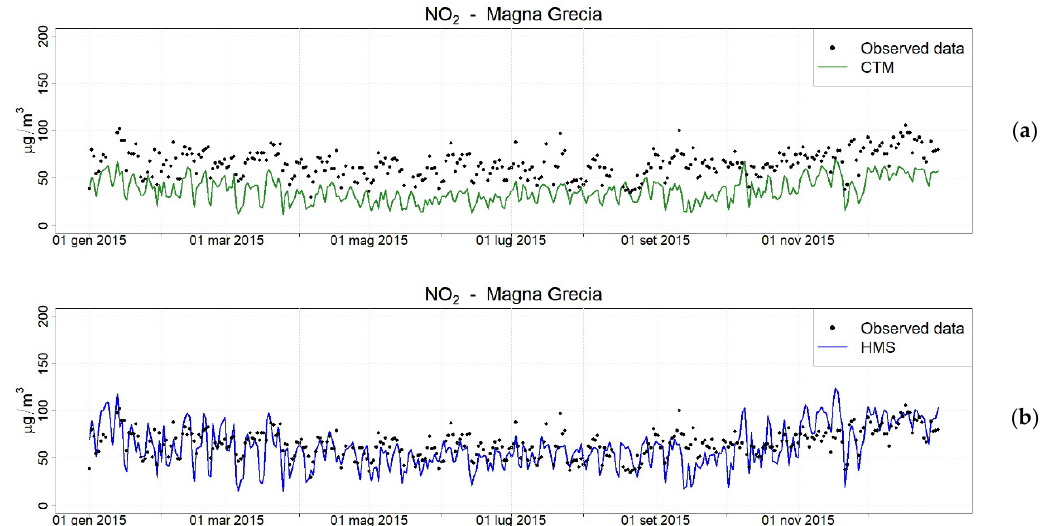
Figure 7. Comparison between observed (black dots) and modelled daily NO 2 concentrations by the CTM FARM run at 1 1 km ( a ) and by HMS (FARM + PMSS) ( b ) at monitoring station Magna Grecia in Rome.